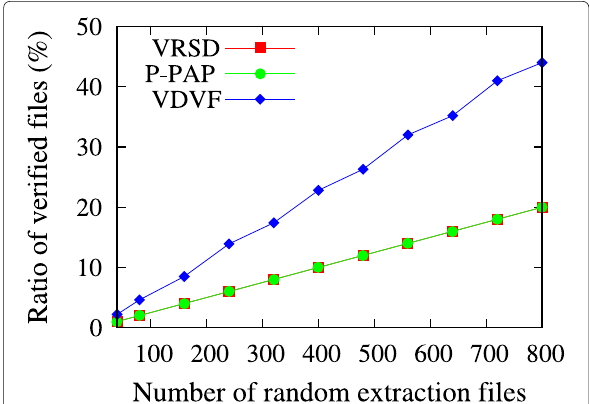
verification of version files. The reason is that these schemes do not distinguish version files and treat them